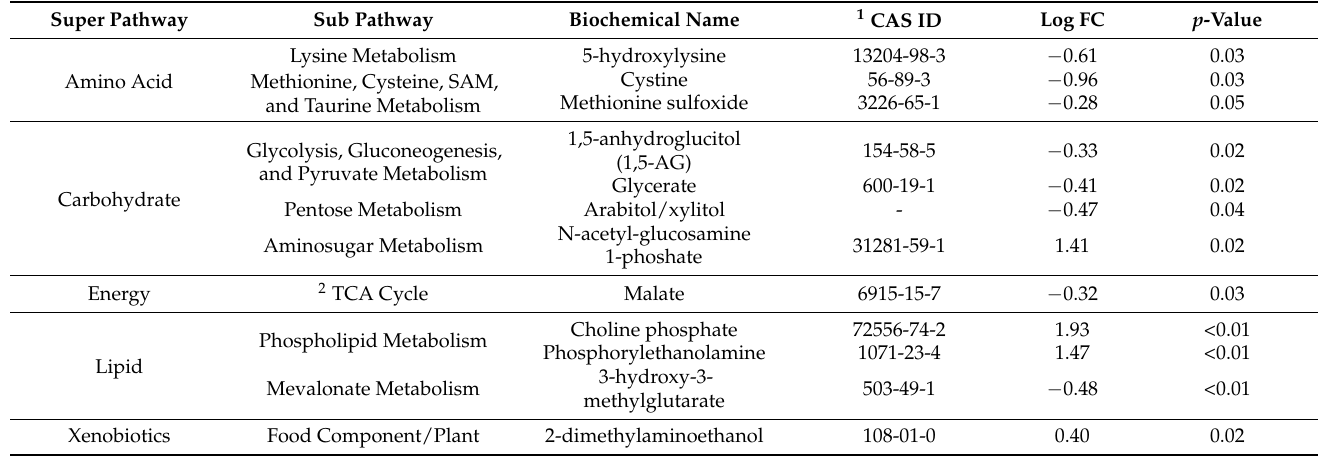
Table 6. Metabolites detected in the milk of cows considered divergent for milk urea nitrogen breeding values (MUNBV) and classified as either high or low when the diet effect (plantain or ryegrass) was controlled for. Log fold change (Log FC) values are calculated with the high MUNBV group as the reference